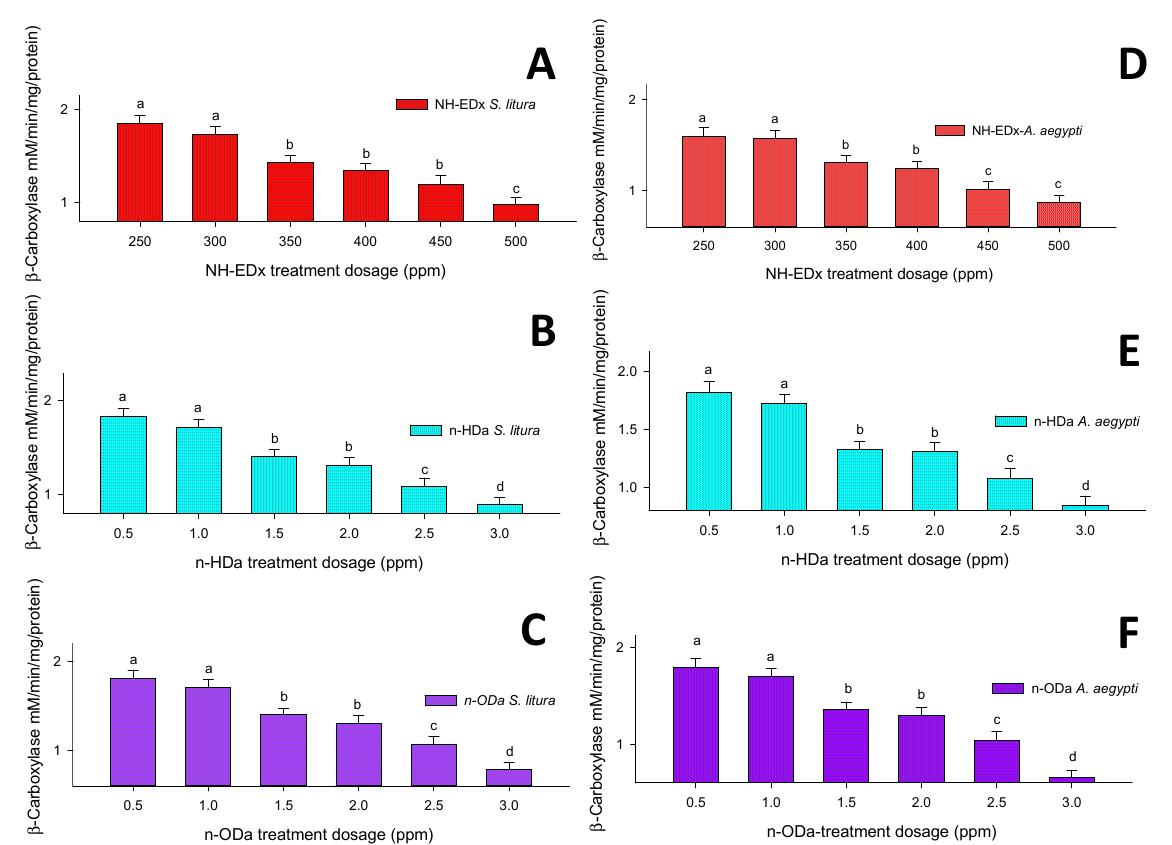
Figure 8. β -carboxylesterase enzyme activity of the fourth instars of S. litura after treatment with ( A ) NH-EDx, ( B ) n -HDa, and ( C ) n -ODa and of fourth instars of A. aegypti after treatment with ( D ) NH-EDx, ( E ) n -HDa, and ( F ) n -ODa, respectively. The data were fitted on a polynomial (regression) model. Vertical bars followed by letters indicate standard error (±SEM).